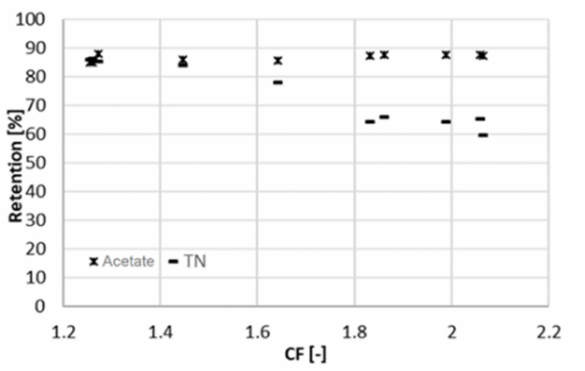
Figure 5. Retention of acetic acid and ammonium (measured as TN) at different concentration factors CF (25 bar).